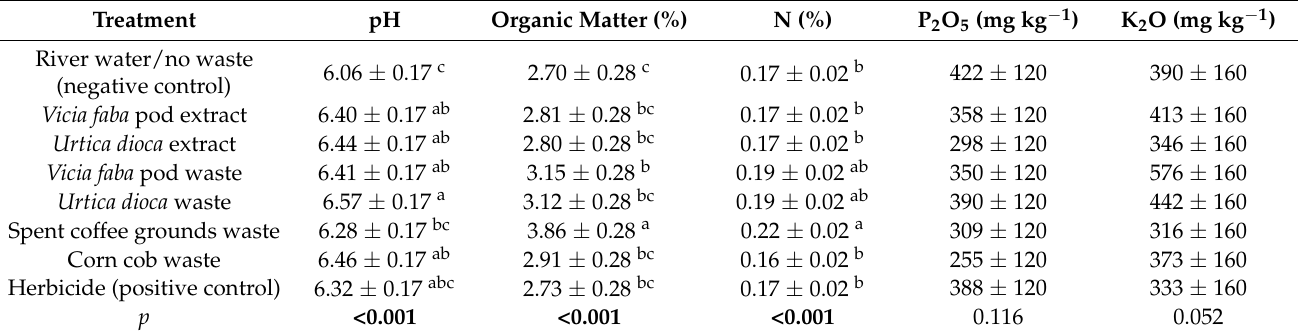
Table 3. Values of soil properties obtained in soils mixed with different waste and collected at the end of Experiment 2 (Autumn pots, 2019). Least-square mean values ( ± confidence intervals) are shown. n = 5. Treatment pH Organic Matter (%) N (%) P 2 O 5 (mg kg − 1